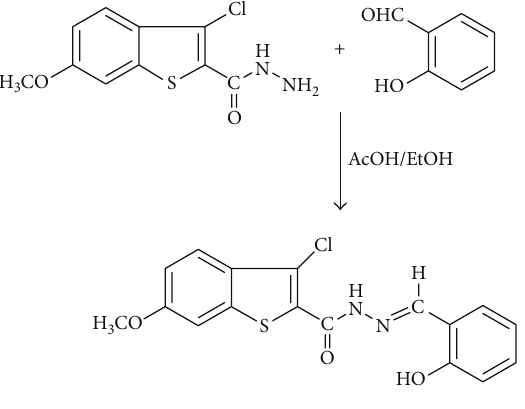
Scheme 1: Synthesis of ligand